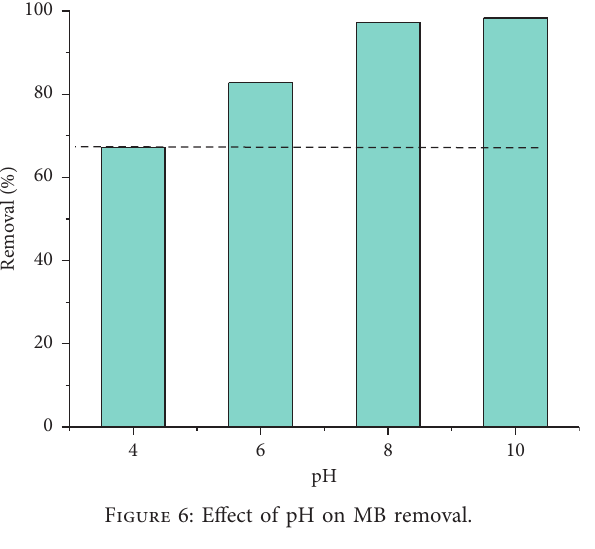
Figure 8: Effect of adsorbent mass.